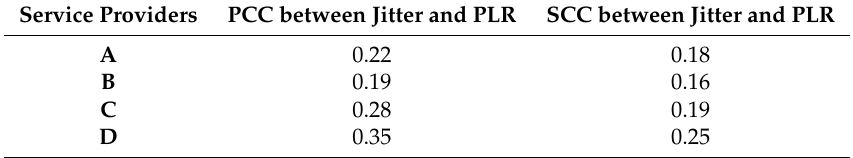
Table 1. Linear and non-linear correlation coefficients between packet loss ratio (PLR) and jitter. Service